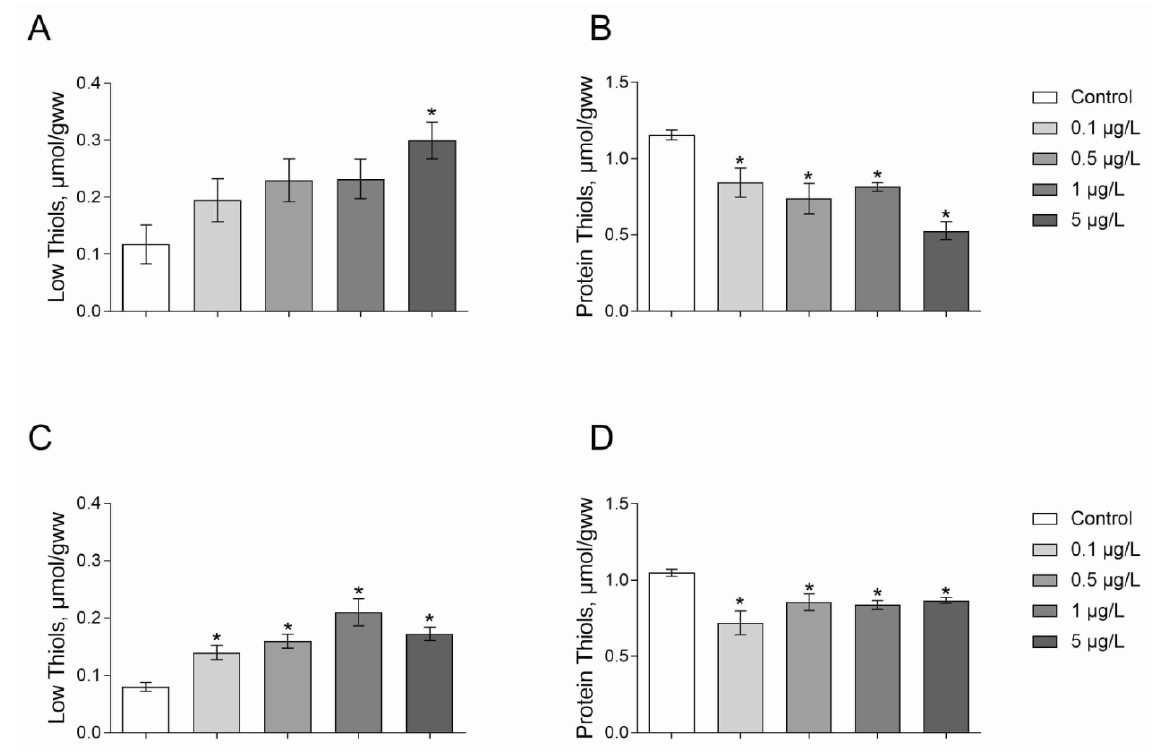
Figure 3: The levels of low-molecular-mass thiols ( A, C ) and protein thiol groups ( B, D ) in 7-8-day-old D. magna exposed to Roundup ( A, B ) or Atrazine ( C, D ) for 24 hours. Values are expressed as mean ± S.E.M. (n = 4-6). *Significantly different with p < 0.05 (ANOVA followed by Dunnett’s multiple compar- ison